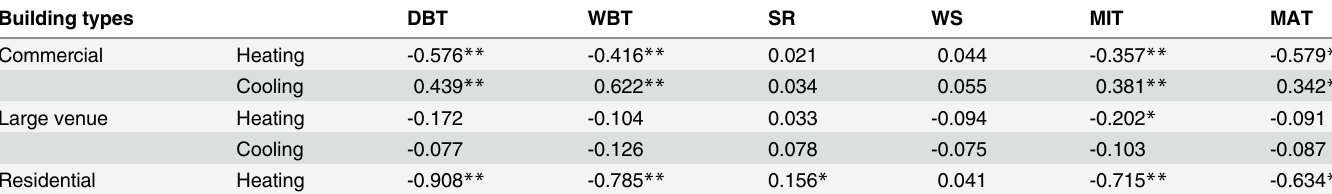
Table 2. Correlations between daily extreme energy consumption and climatic parameters for different kinds of buildings.